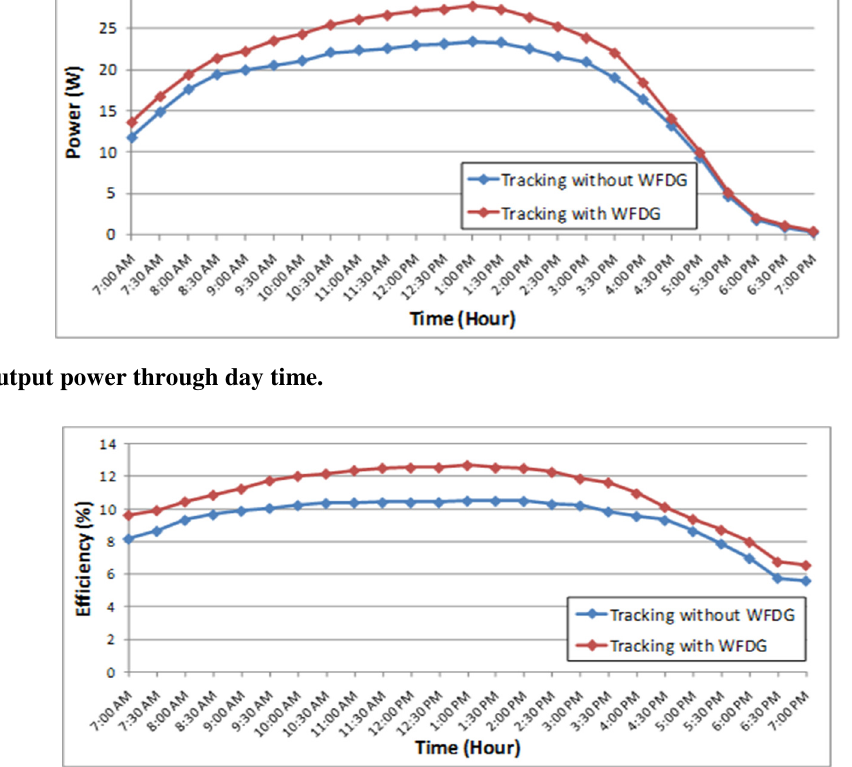
Fig. 10. Panel efficiency through day time.